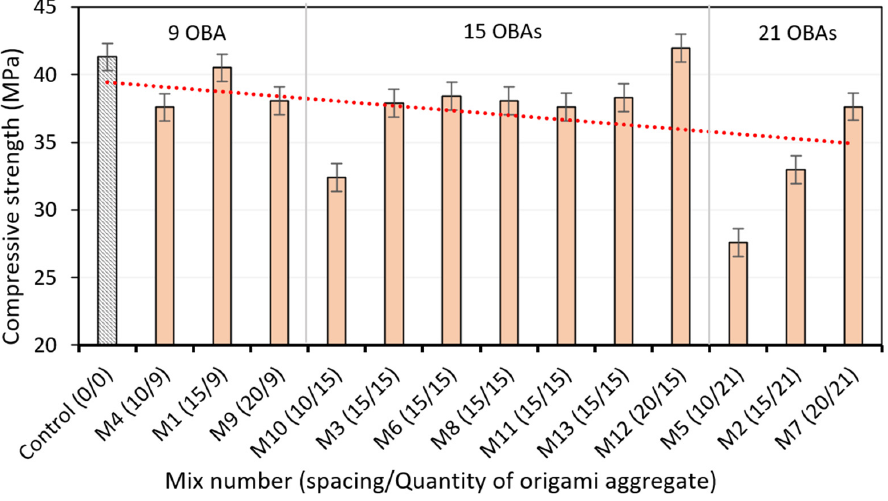
Figure 7. Compressive strength of OBA ‐ RECC mixes at 28